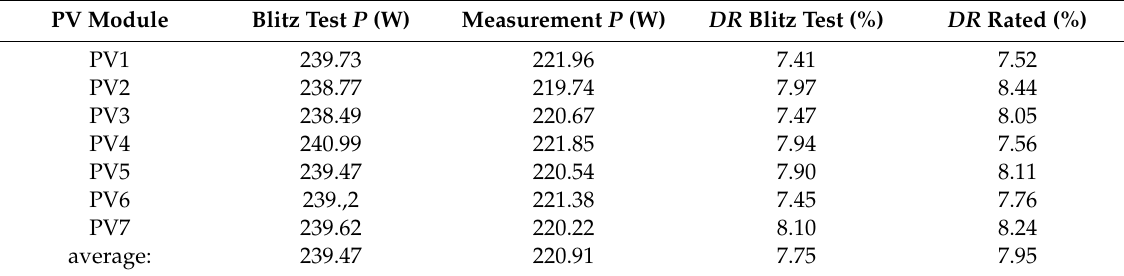
Table 4. PV module blitz test and measurement power and degradation rate level.